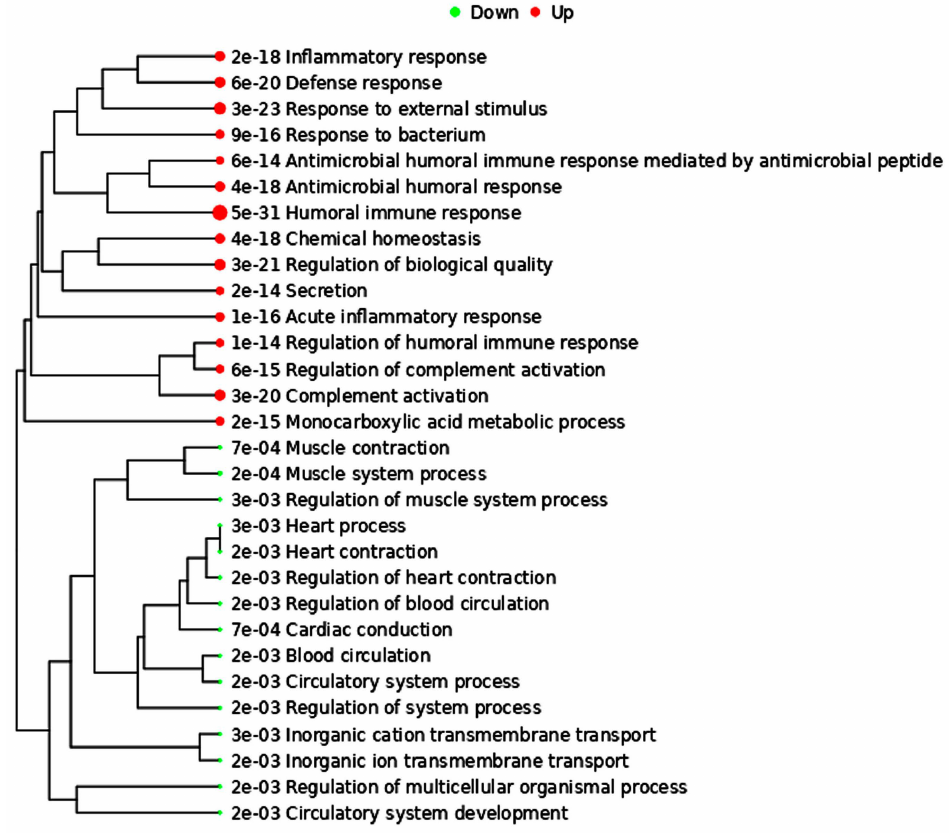
Figure 2. Gene ontology classification of genes according to biological processes. Red dots denote upregulation, and green dots denote